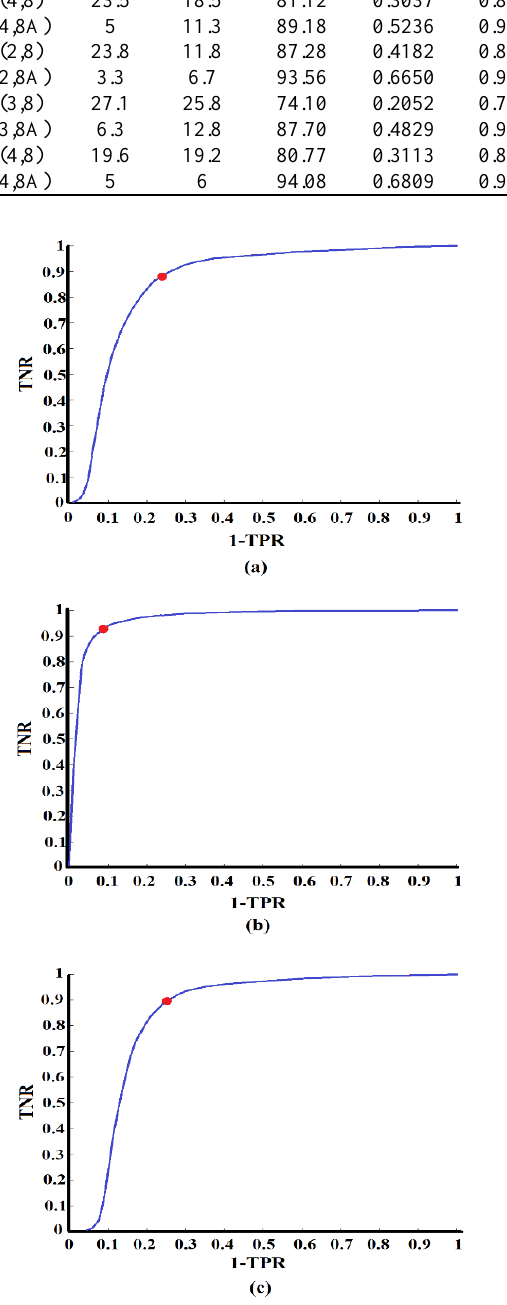
Figure 7. ROC curves for spectral feature R(2)/R(8) (a), R(4)-R(8A) (b) and [R(4)-R(8A)]/[R(4)+R(8A)] (c). The red dot shows the index’s ideal